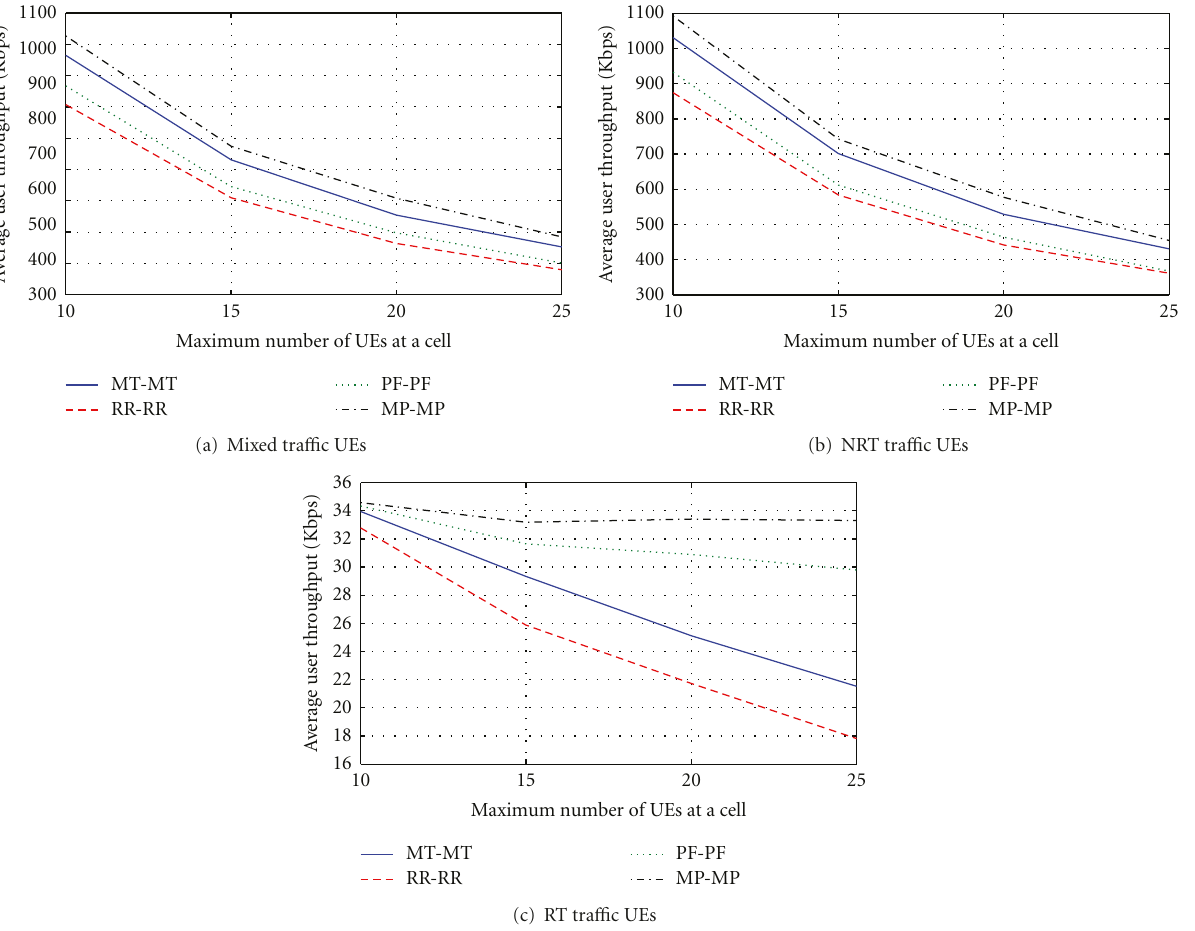
Figure 3: Average user throughput versus maximum number of UEs in a cell.